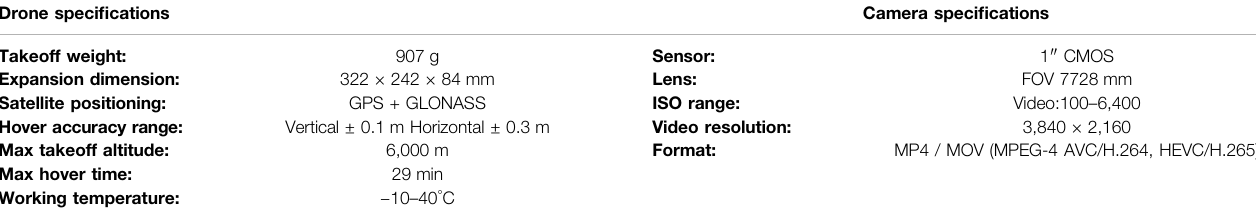
TABLE 2 | The DJI Mavic2 speci fi cations (from https://www.dji.com). Drone speci fi cations Camera speci fi cations Takeoff weight: